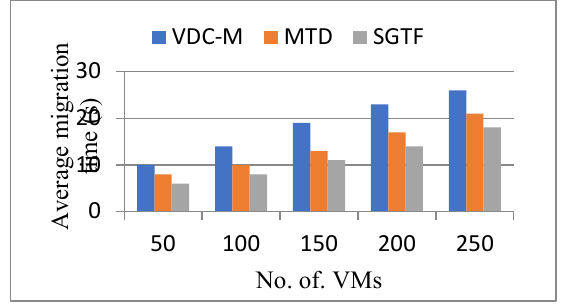
Figure.7. Performance comparison of total completion time against number of virtual machines